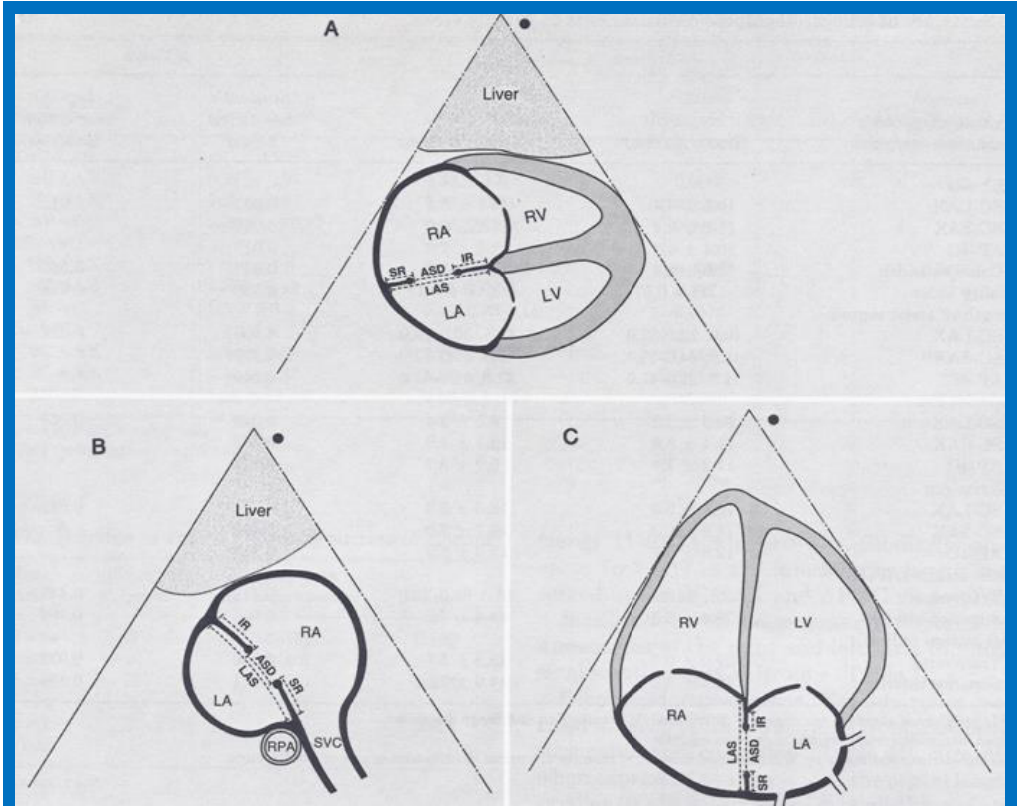
Figure 5. Drawings of 2D echo images of the atrial septum in subcostal long-axis ( A ), subcostal short-axis ( B ), and apical four-chamber ( C ) views demonstrating how measurement of the atrial septal defect (ASD), length of the atrial septum (LAS), superior rim (SR), and inferior rim (IR) are obtained. LA, left atrium; LV, left ventricle; RA, right atrium; RPA, right pulmonary artery; RV, right ventricle; SVC, superior vena cava. Reproduced from Reddy S.C.B., et al. [7].